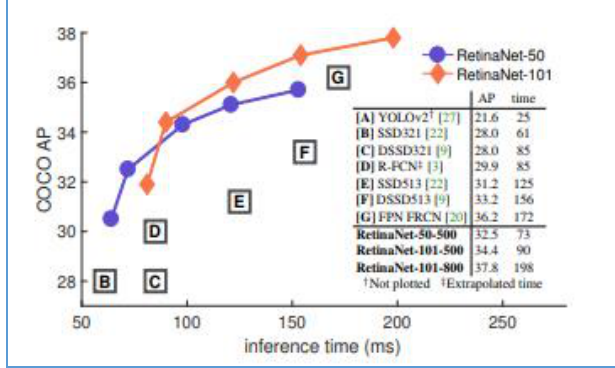
Figure 1. Literature Survey for state of art DL for normal object detection [12]. (2017. Recent new state of art DL networks has come but they can fit directly here in this